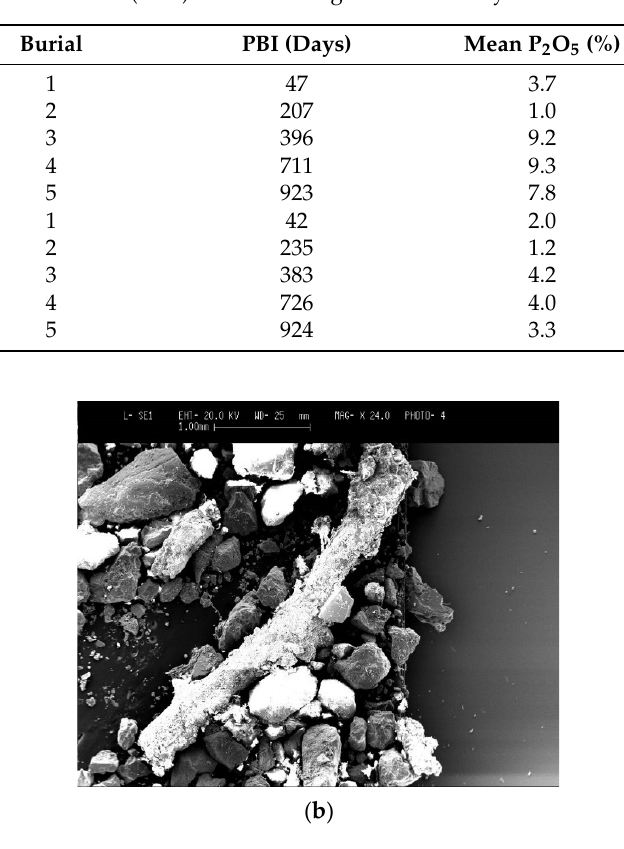
Figure 5. Mean phosphate concentration (P 2 O 5 ) detected in “dust” soil specimens sampled from site A and B at different PBIs. The box plots show the minimum value, the maximum value, the sample median, and the first and third quartiles. Data obtained from SEM-EDS analysis. Table 4. Summary of the mean phosphate concentration (P 2 O 5 ) found in each “dust” sample from site A and B at different Post Burial Intervals (PBIs) obtained using SEM-EDS analysis.